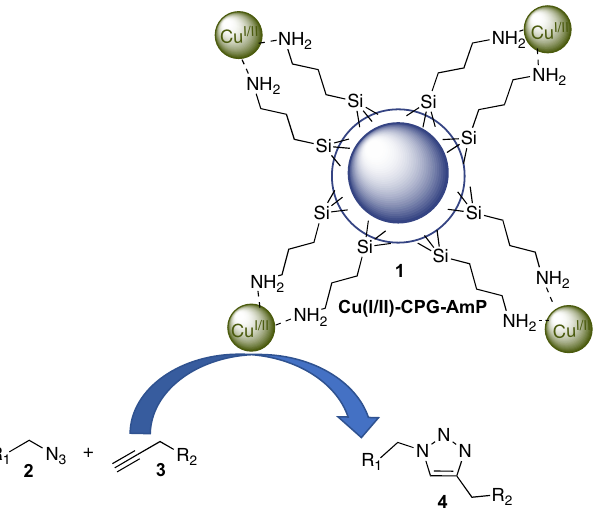
Figure 1. Cu-AmP-CPG ( 1 )-catalyzed 1,3-dipolar cycloaddition between azides 2 and propargyl alcohols 3 .